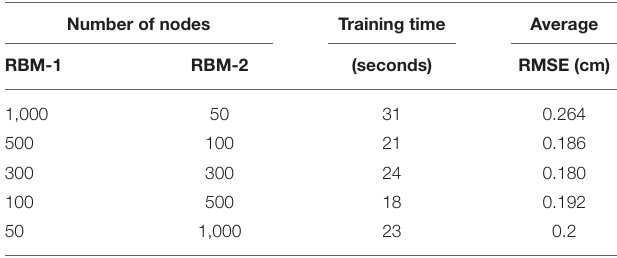
TABLE 2 | Effect of the number of nodes in a 2-layer DBN on the model